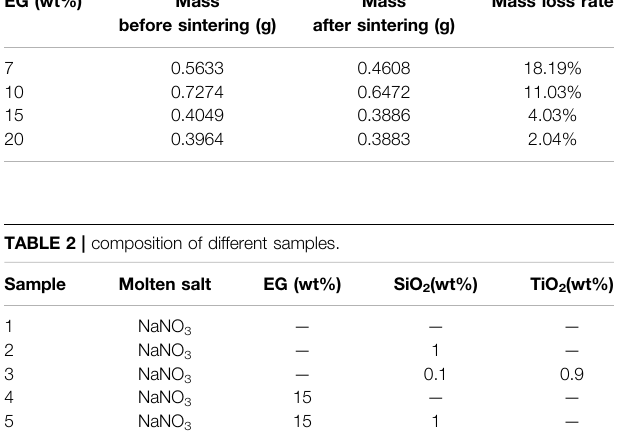
TABLE 1 | mass loss rate of composites with different EG content. EG (wt%)